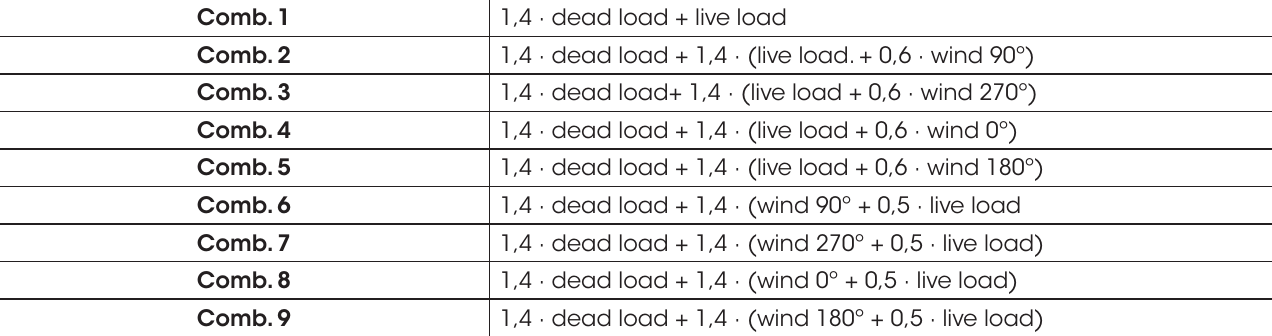
Table 1 Load combination